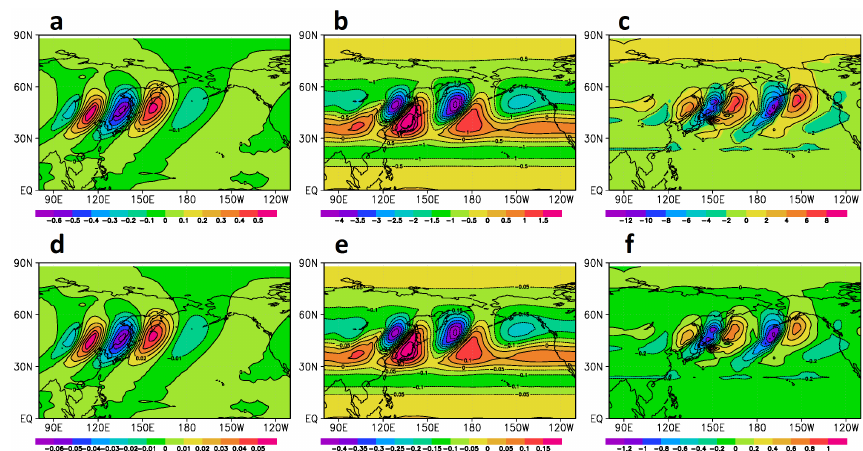
Figure 5. Evolution of different initial perturbations for the V-wind fields (ms − 1 ) . Upper panel (a, b, c) shows wind with 10% perturbation of the initial state and lower panel (d, e, f) with 1% perturbation (see details in Sect. 3.2). The shadings represent the difference between the two nonlinear models runs with perturbed and unperturbed initial conditions. The contours illustrate the evolution of wind perturbation propagated by the tangent linear model at different times, the initial time (left column), 24h (middle), and 48h (right).